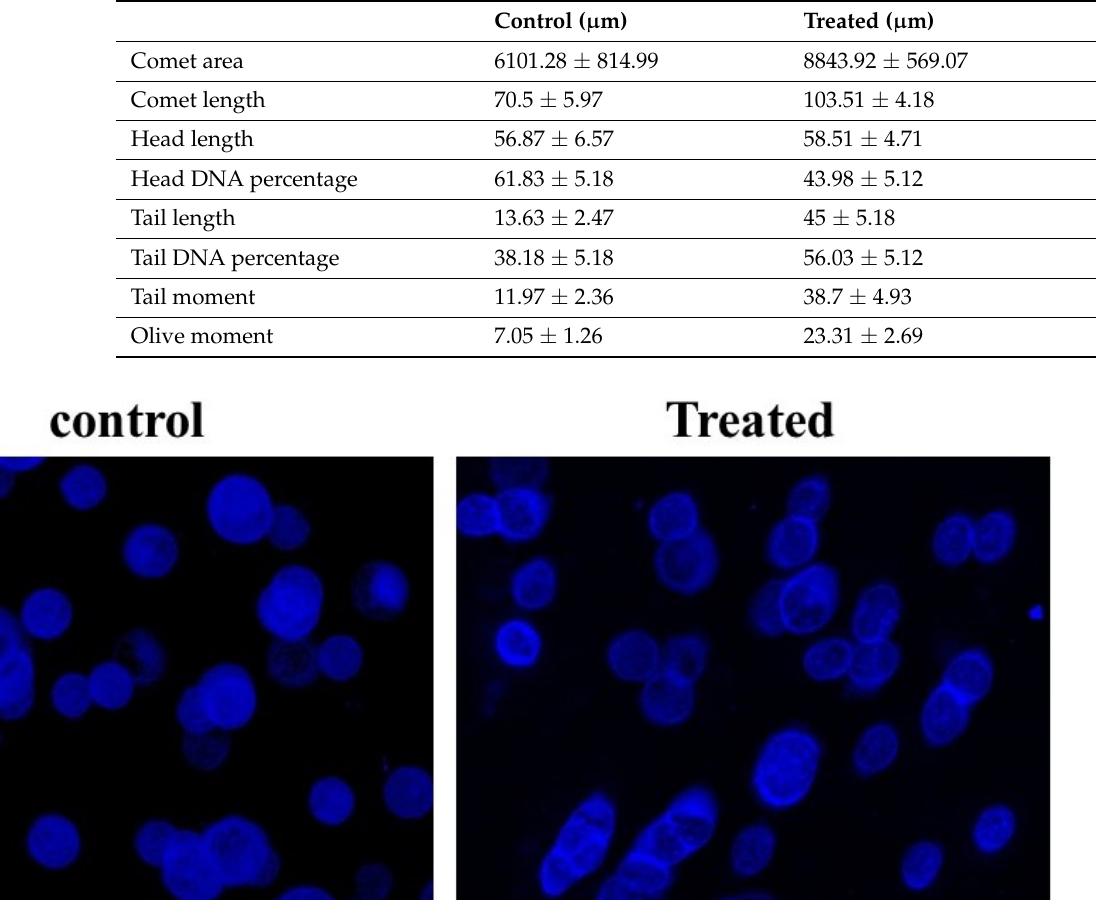
Table 1. Comet score depicting DNA damage as a result of CMBNPs treatment in HT-29 cells.